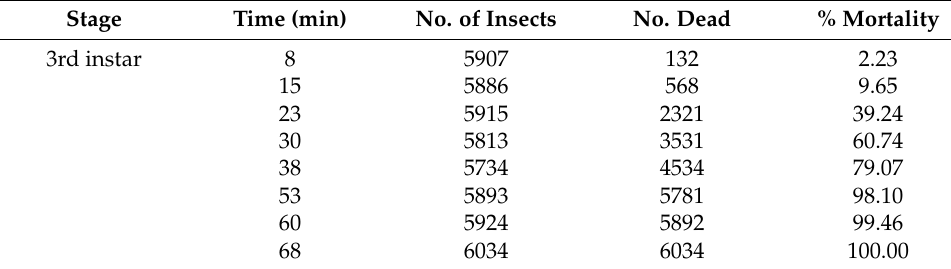
Table 3. Probit model estimates of time required to achieve 50%, 90%, 99%, 99.9%, 99.99%, and 99.9968% mortality of